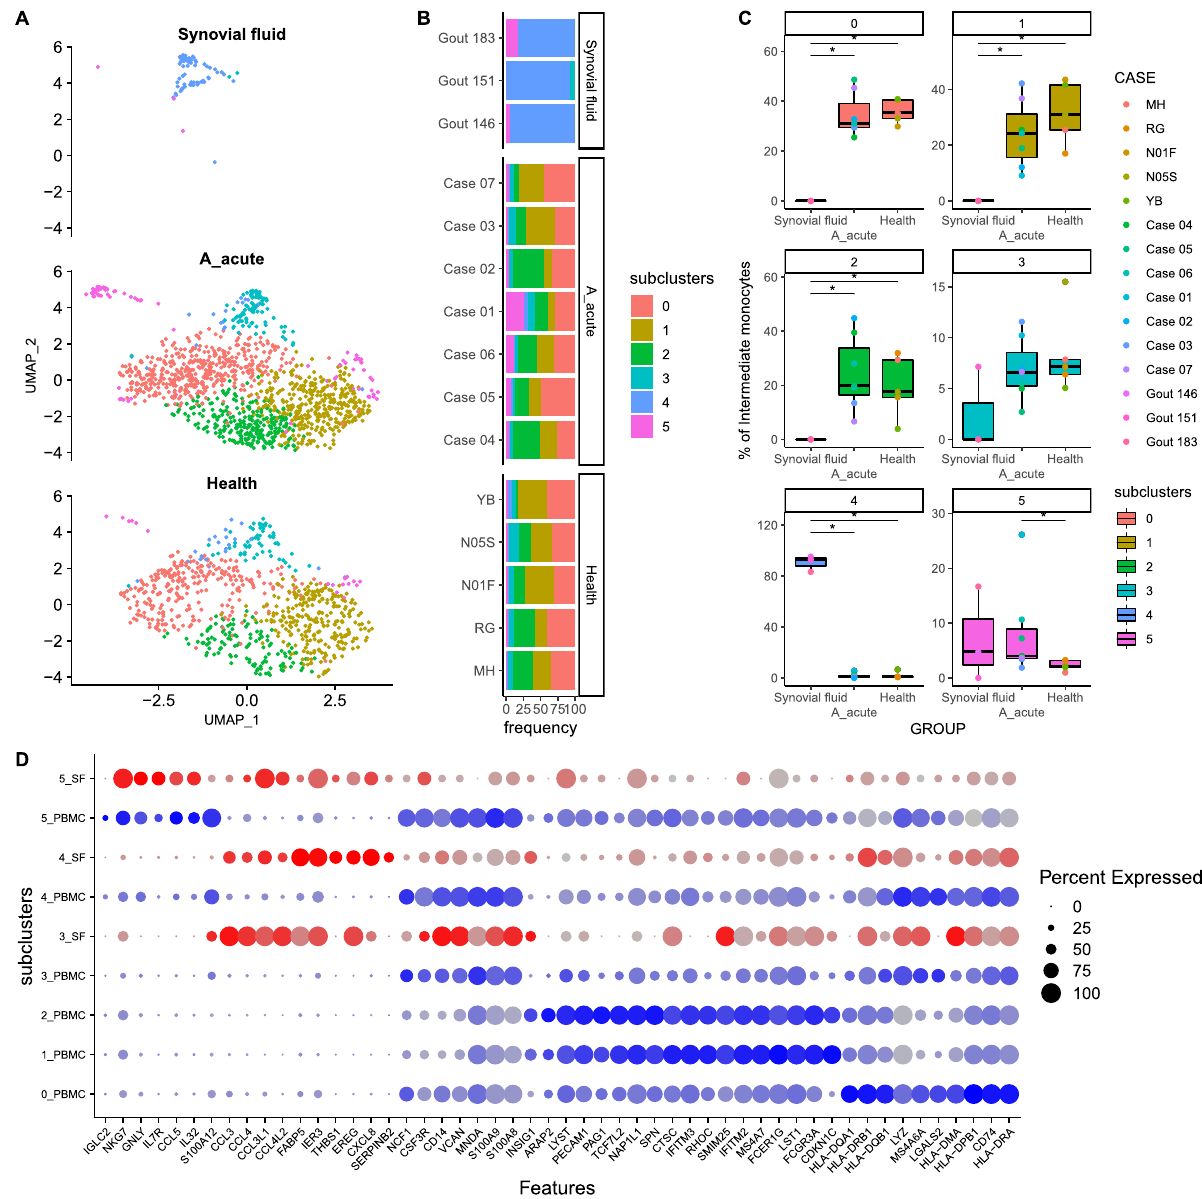
Figure 3. Intermediate monocyte subclustering results for ( A , B ) SF and PBMCs from acute gout and healthy subject groups are shown on UMAP coordinates. Stacked bar plot shows relative abundances. ( C ) Boxplots of subcluster relative abundance between SF samples and PBMCs of acute gout and healthy subject groups (* P < 0.05). ( D ) Dot plot of gene expression profiles of the top 10 marker genes in each